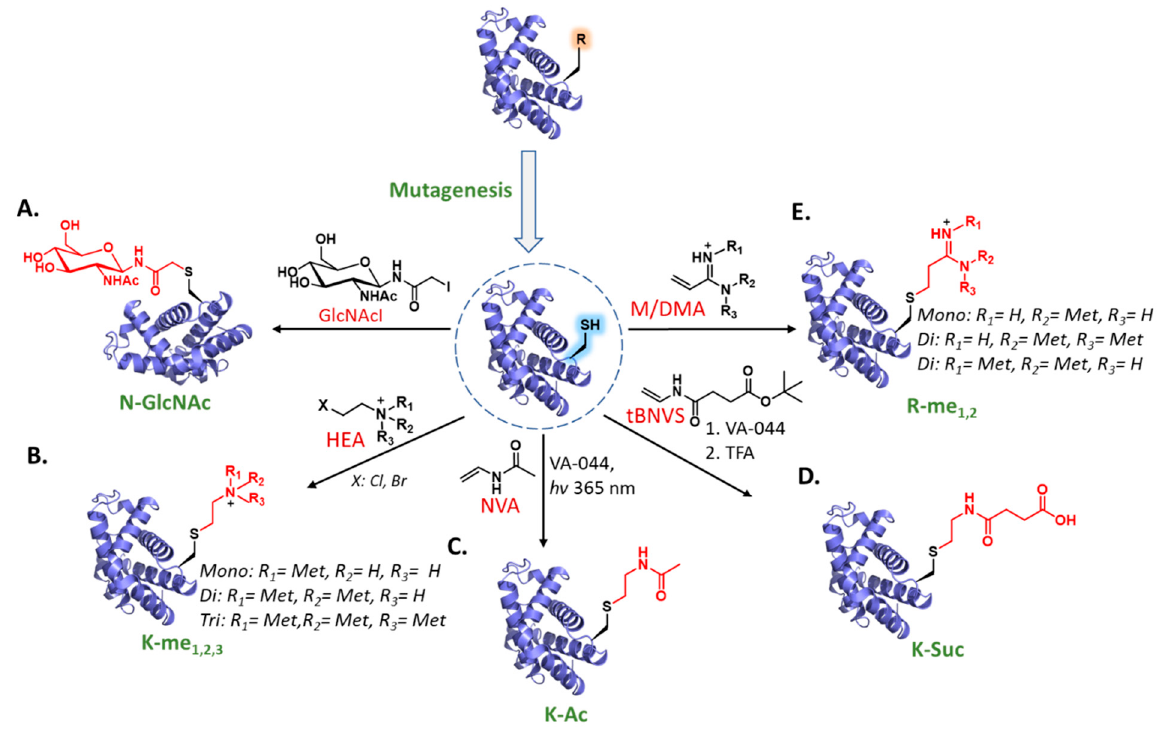
Figure 2. Chemical mutagenesis via late-stage Cys functionalization. Chemoselective incorporation of PTM mimics via direct Cys modification: ( A ) Asn glycosylation; ( B ) Lys methylation; ( C ) Lys acetylation; ( D ) Lys succinylation; ( E ) Arg methylation.